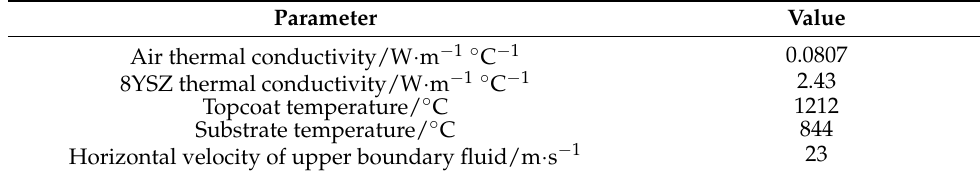
Table 1. Calculation parameters of the numerical